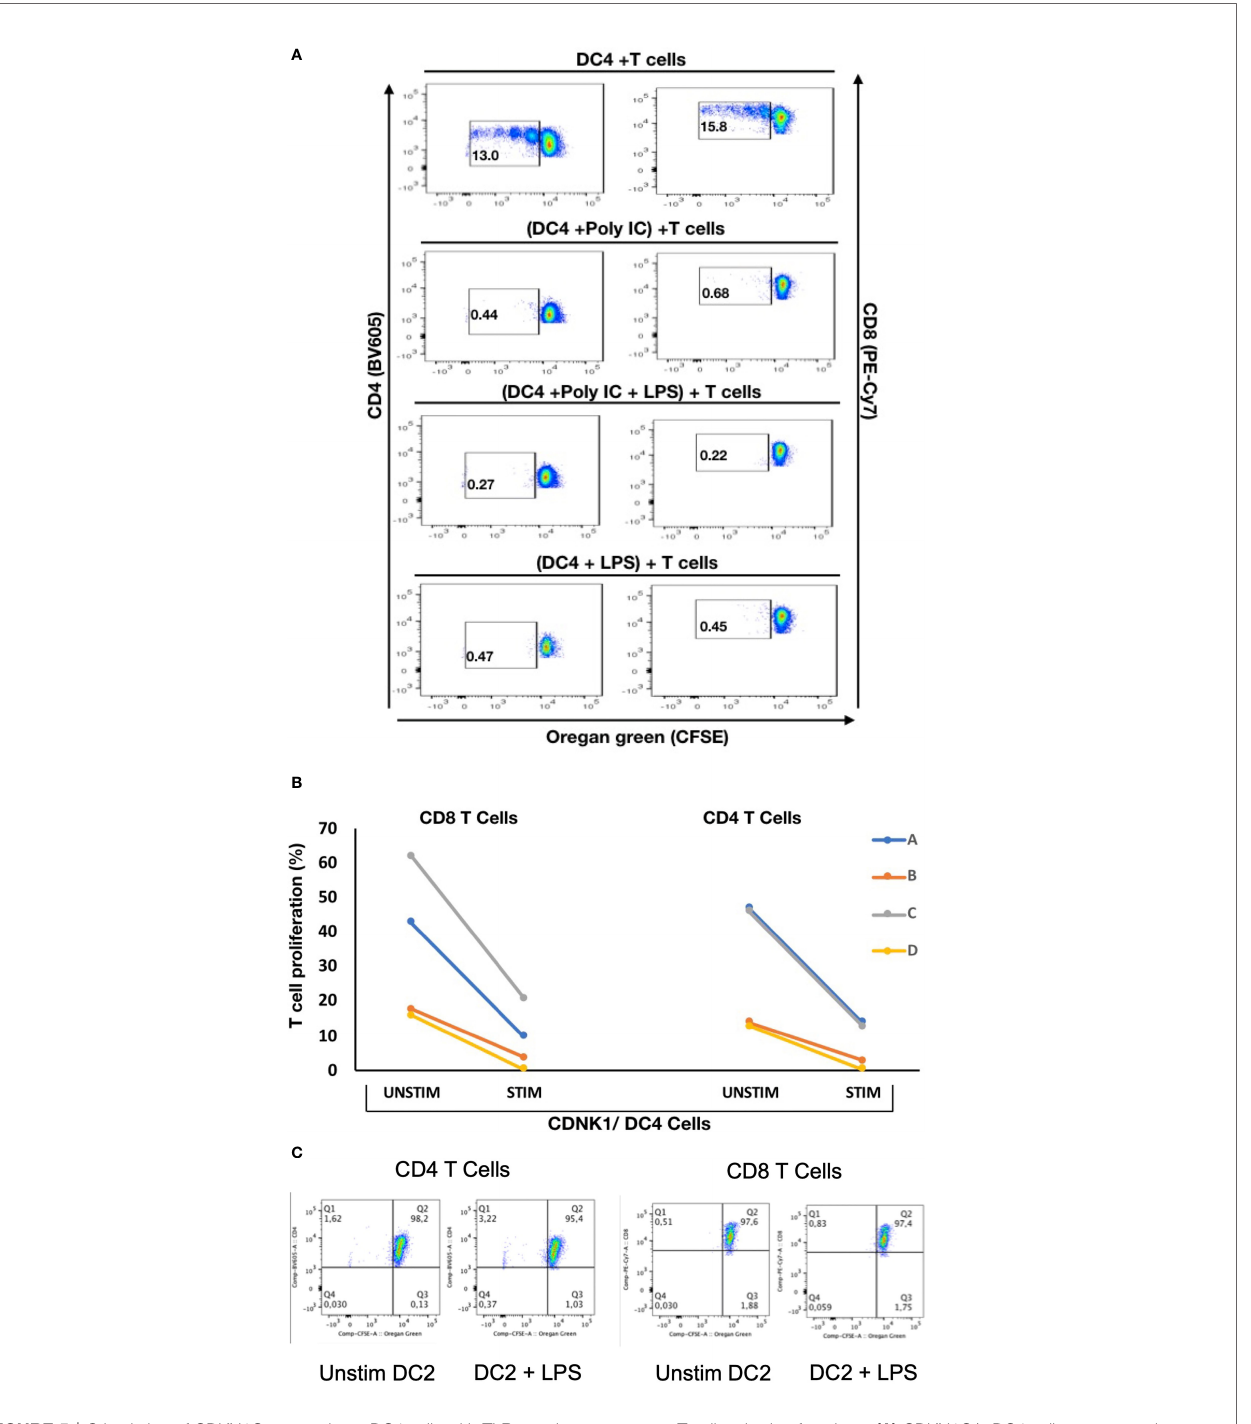
FIGURE 5 | Stimulation of CDKN1C-expressing mDC4 cells with TLR agonists suppresses T cell activation function – (A) CDKN1C/mDC4 cells were sorted as viable, singlets, CD14 - , CD19 - , CD3 - , HLA-DR int-to-high , CD11c + , CD16 + cells, stimulated with polyI:C and/or LPS and mixed with autologous T cells labelled with Oregon Green (OG) from the same patient. (Note that CD16 is encoded by FCGR3A expressed in CDKN1C-expressing mDC4.) Following 5 days, samples were analyzed by fl ow cytometry. Proliferating T cells (lower OG staining) were gated. The pseudocolor dot plots are representative of 4 different experiments. (B) Percent of CD4 and CD8 T cells proliferating using sorted cells from four different individuals (A – D) with or without stimulated. Proliferation was assessed using OG staining after co-culture of autologous T cells with CDKN1C-expressing mDC4 cells for 5 days induced by mDC4 either unstimulated or pre-stimulated with the TLR3 agonist polyI:C. (C) mDC2 stimulation of autologous T cells - T cell proliferation assays with unstimulated or LPS-stimulated mDC2 dendritic